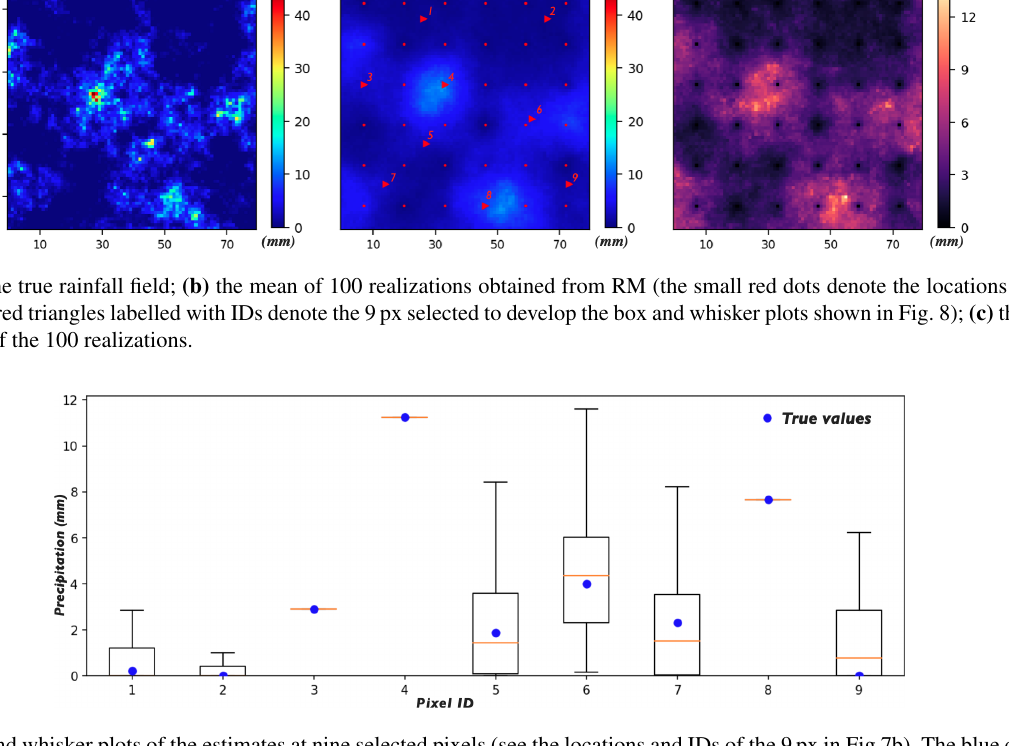
Figure 8. Box and whisker plots of the estimates at nine selected pixels (see the locations and IDs of the 9px in Fig 7b). The blue dots denote the true values, i.e. the values at the corresponding pixels in the true field.